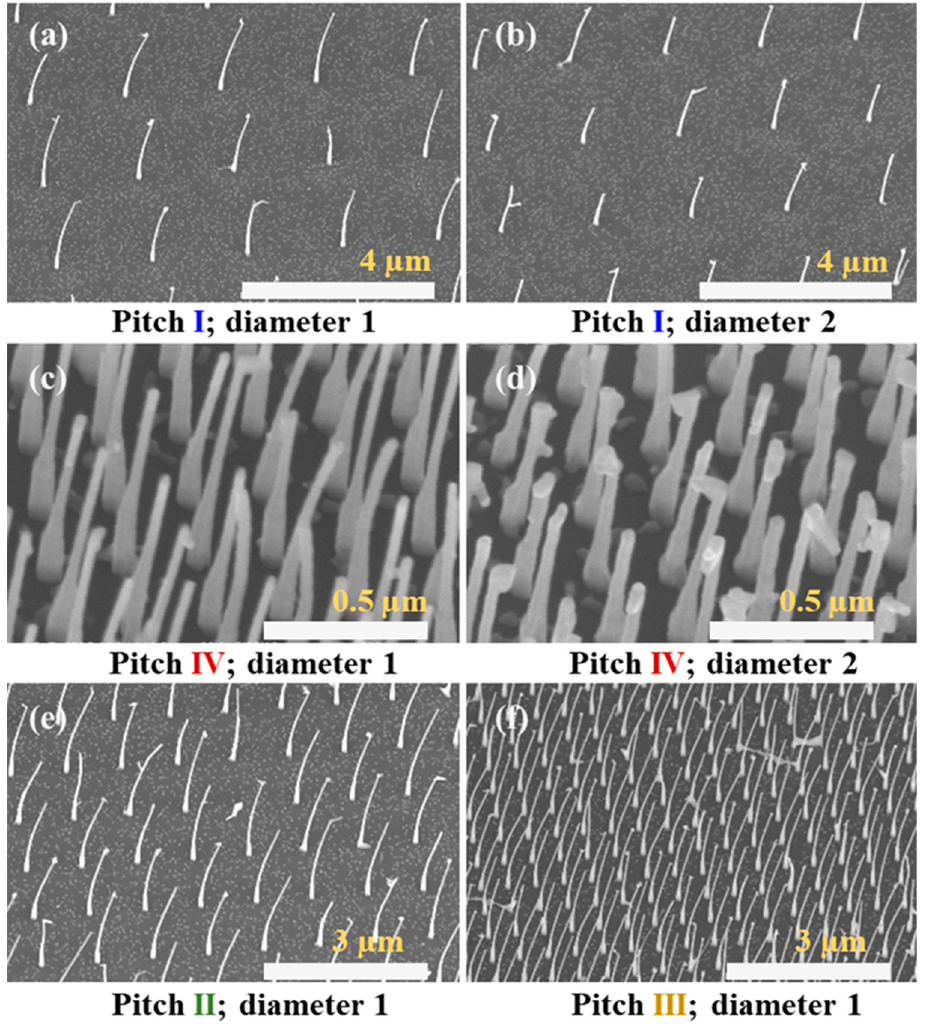
Figure 2. SEM images of bent heterostructure grown from catalysts of various pitch and diameter, with diameter 1 (~38 nm) and diameter 2 (~43 nm), and wire pitch of ( a,b ) 2 µm, ( c,d ) 0.25 µm, ( e ) 1 µm, and ( f ) 0.5 µm. The main finding was the reduction of bending with increasing NW density and diameter.